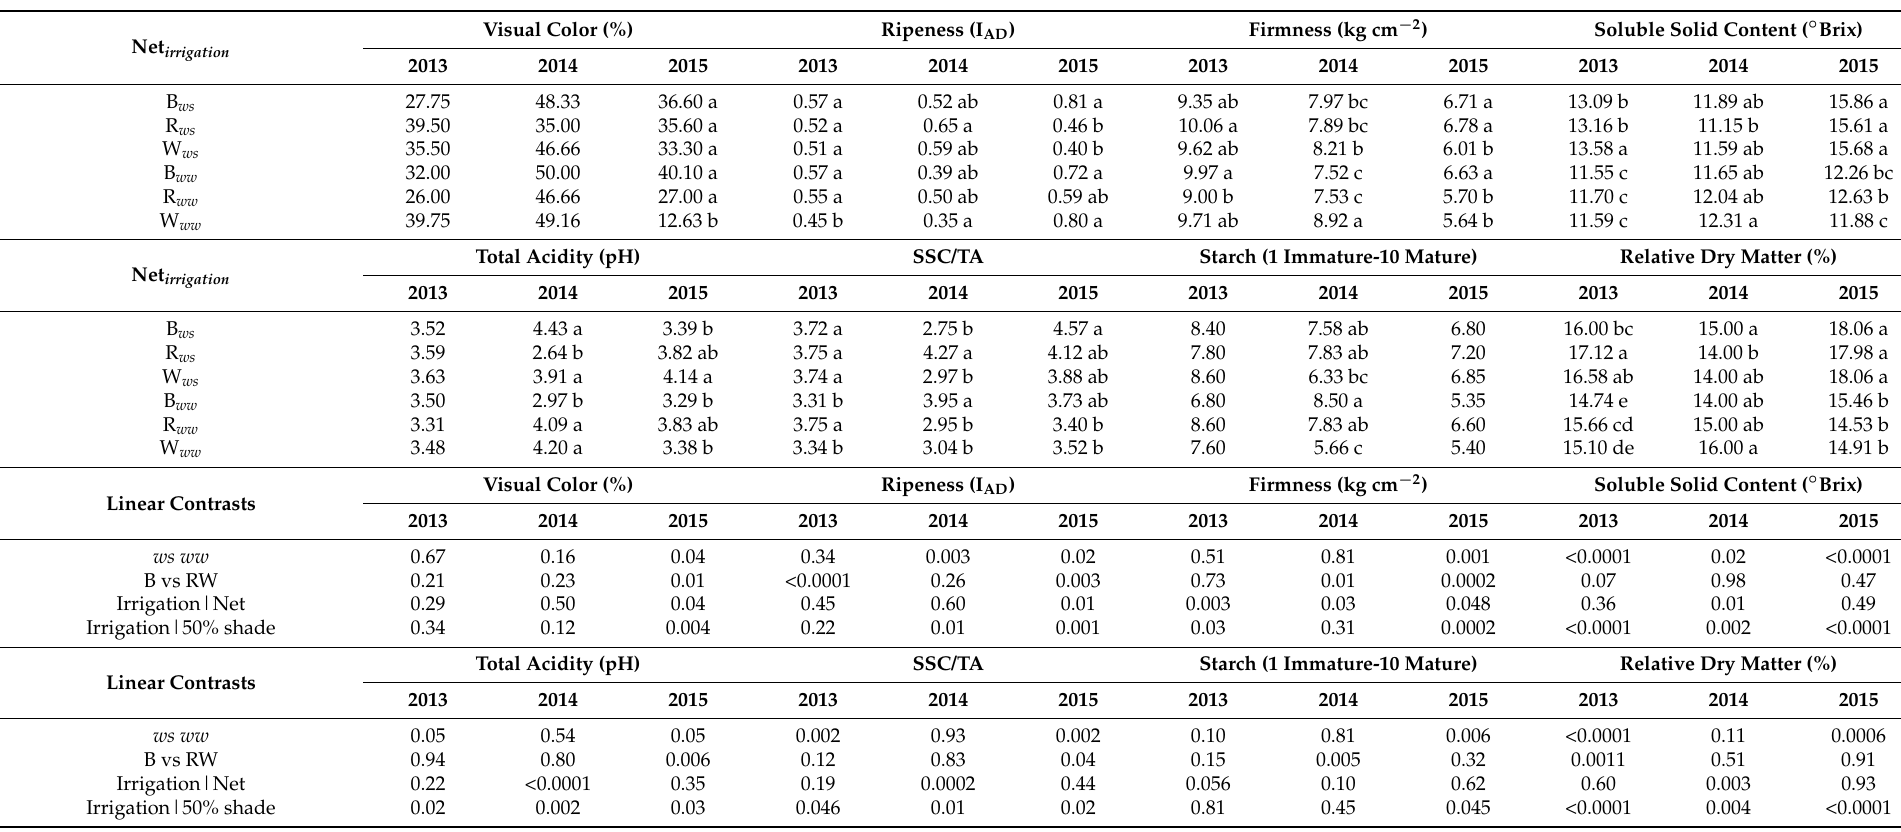
Table 8. Effect of shading and irrigation on fruit quality traits during the years 2013, 2014, and 2015. The presence of different letters indicates significant differences at p < 0.05. No letters indicate no significant differences. In the lower part of the table, F values of linear contrast for each year are shown; values below 0.05 are considered